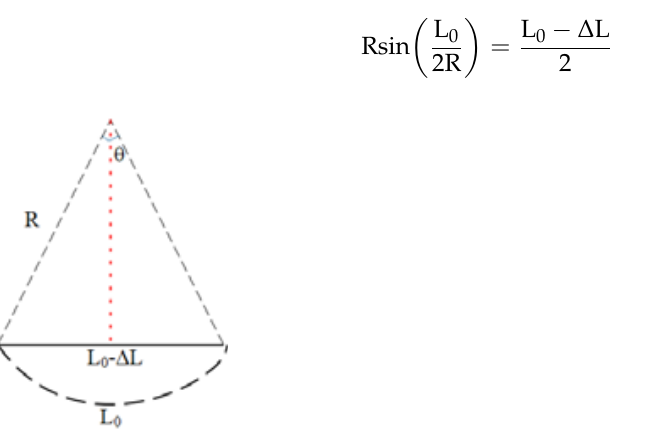
Figure 10. Schematic diagram of curvature change of the sensor.